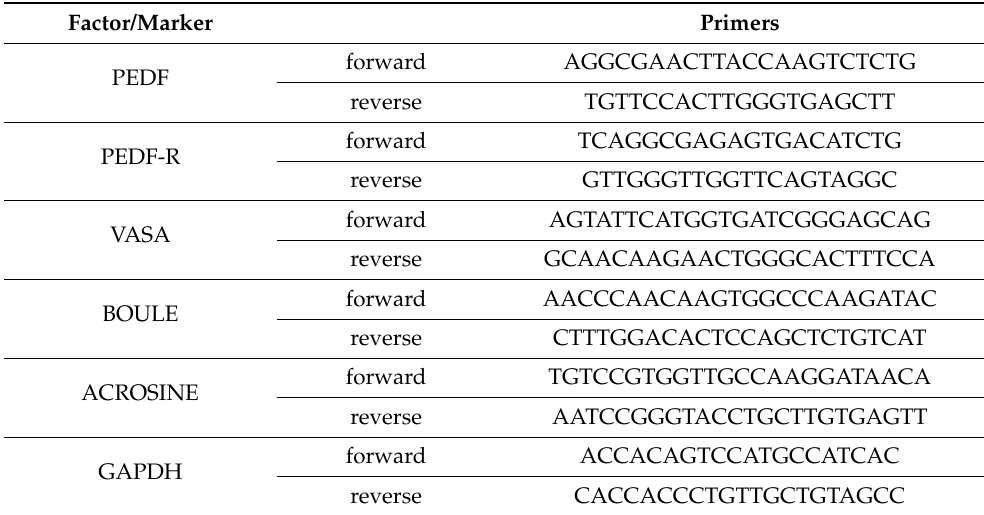
Table 1. Primers used to evaluate the expression levels of factors or spermatogenic